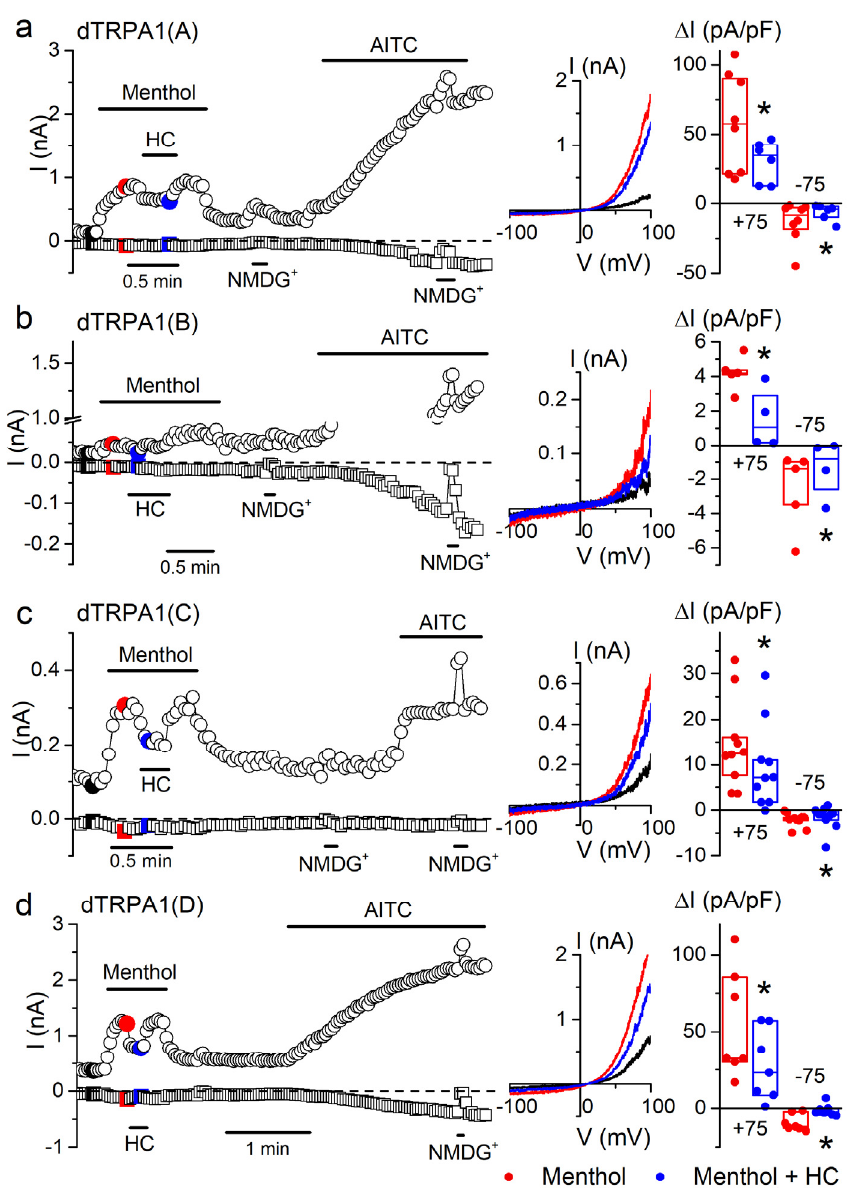
Figure 6. Menthol increases whole-cell currents in the four dTRPA1 isoforms. ( a – d ) Example of the effects of menthol (1 mM), HC-030031 (HC; 100 µ M) and AITC (100 µ M) on the amplitude of whole-cell currents measured at +75 mV (circles) and − 75 mV (squares) in HEK293T cells expressing either dTRPA1(A), dTRPA1(B), dTRPA1(C) or dTRPA1(D). An extracellular solution where all cations were replaced by N -methyl- D -glucamine (NMDG + ) was used to assess the size of leak currents. The middle insets show current traces recorded at the time points indicated by the corresponding colors in the left panels. The dot plots on the right show the change in current density amplitude with respect to baseline values (+75 mV and − 75 mV). The horizontal lines represent the medians and the boxes represent the 25-75 percentiles. Application of menthol (1 mM, red symbols) increased whole-cell current in cells expressing: dTRPA1(A) ( p = 0.001, n = 8), dTRPA1(B) ( p = 0.0003, n = 5), dTRPA1(C) ( p = 0.0006, n = 10) or dTRPA1(D) ( p = 0.003, n = 7, one-sample t -test vs. 0). The TRPA1 blocker HC-030031 (HC; 100 µM) partly inhibited menthol-induced currents (blue symbols) in cells expressing dTRPA1(A) ( p = 0.04, n = 6-8), dTRPA1(B) ( p = 0.024, n = 4-5; two-sample t -test), dTRPA1(C) ( p = 0.0004, n = 10) or dTRPA1(D) ( p = 0.004, n = 7; one tailed paired sample t -test). * p < 0.05.